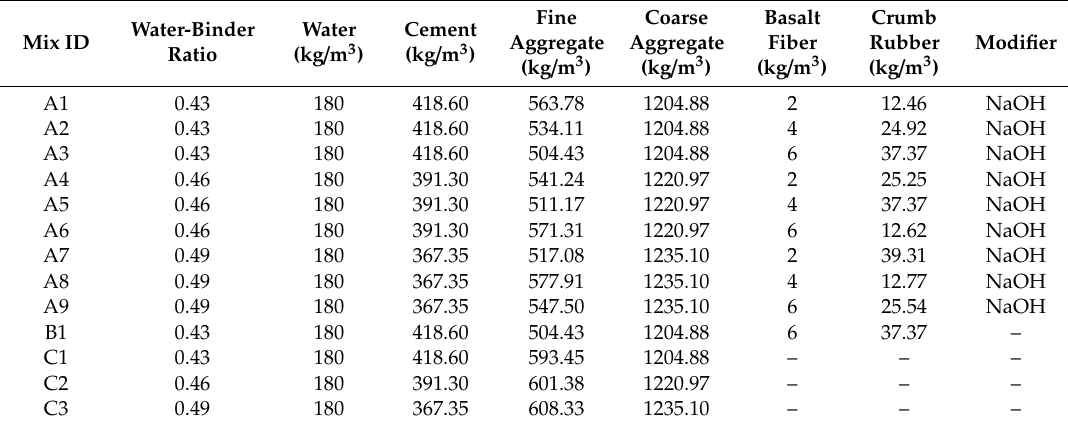
Table 6. The mix proportion of CRBFC.